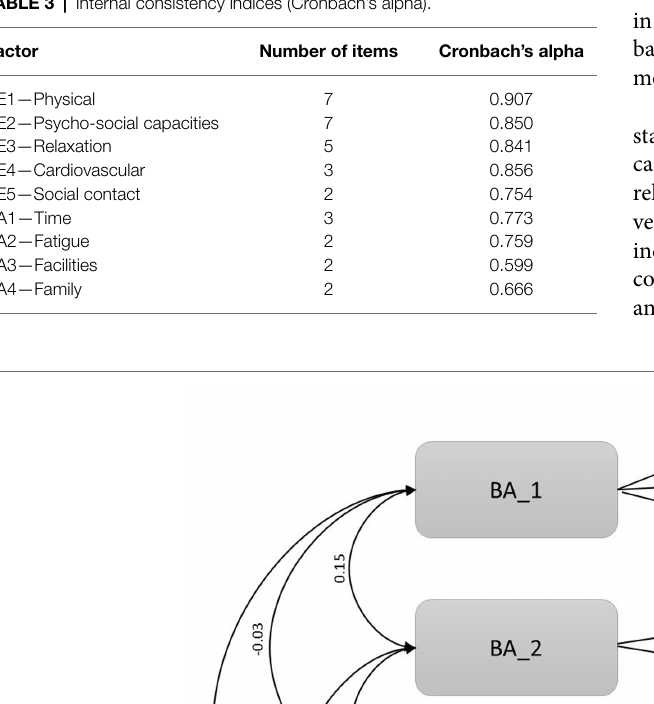
TABLE 3 | Internal consistency indices (Cronbach’s